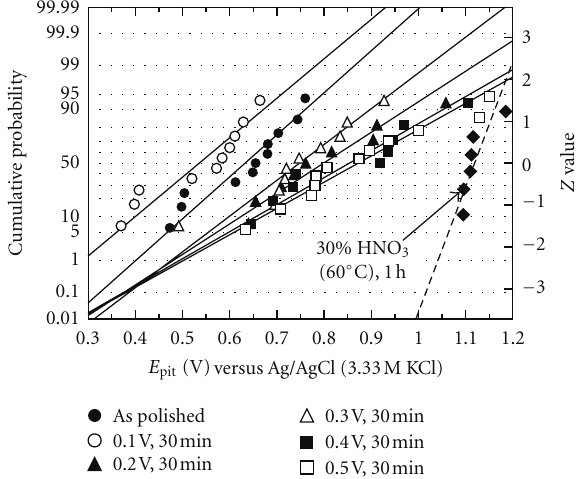
Figure 6: Normal probability plots of onset potential of stable pitting, E pit , in 0.5 M NaCl for commercial Type 316L stainless steels after polarization treatments at di ff erent potentials for 30min in 1M Na 2 SO 4 of pH 3. The data for nitric acid passivation is shown for